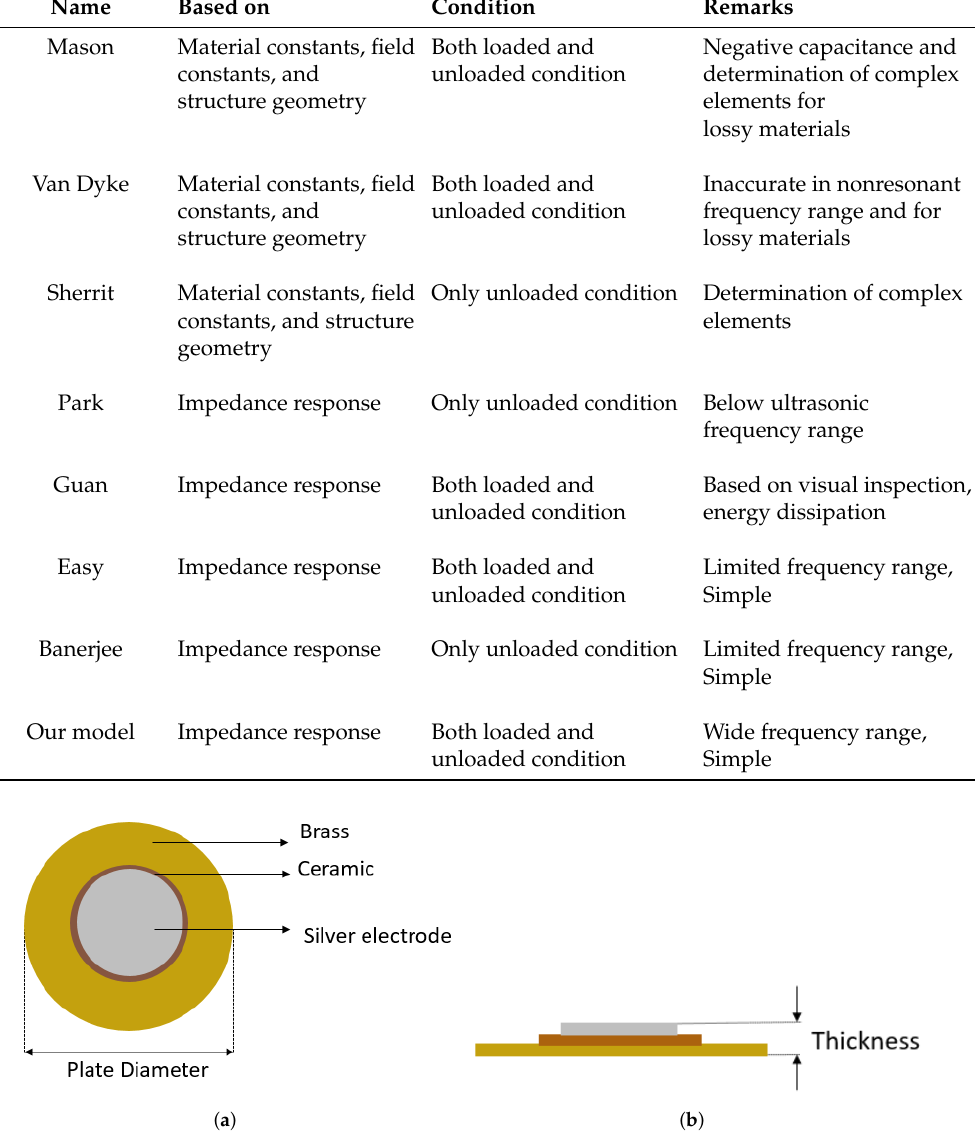
Table 1. Overview of existing models.